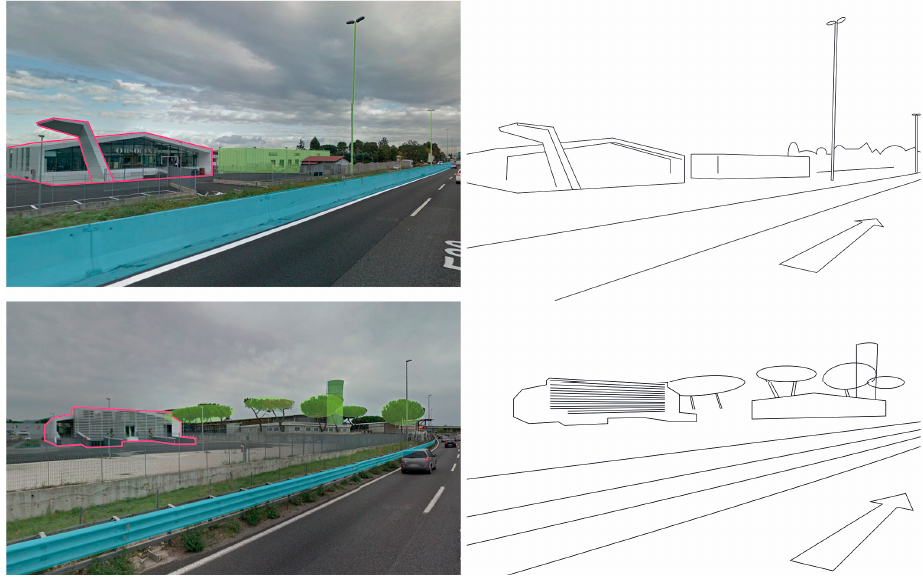
Figure 3. Perceptual influence of the “landmark” according with Cullen’s studies (image by Rosario Di